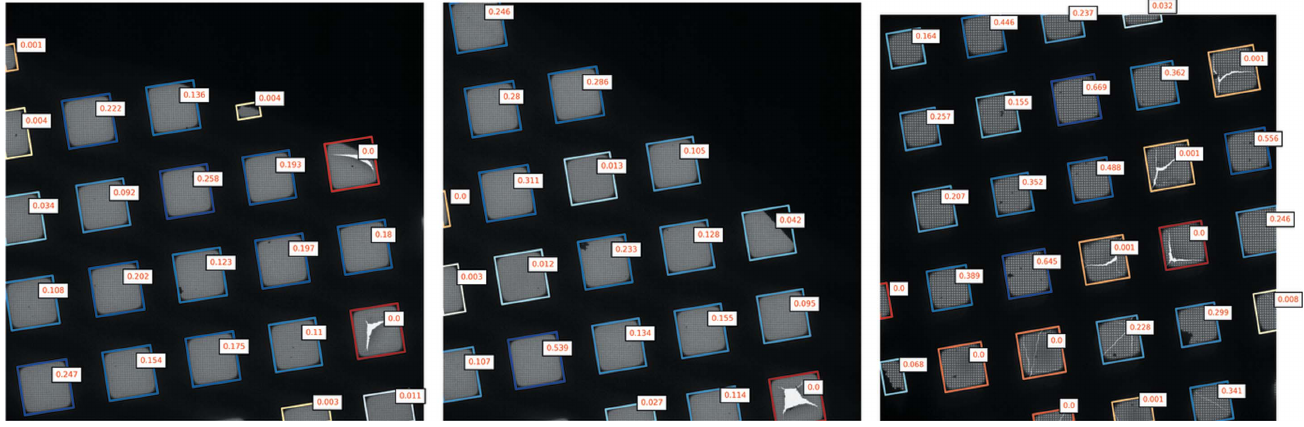
Figure 9 Example square classifications in low-magnification images. The model successfully prioritizes larger, brighter squares without cracks or contamination. Model-predicted probabilities for squares are in red. Colors from high to low score: dark blue, light blue, white, yellow, orange,